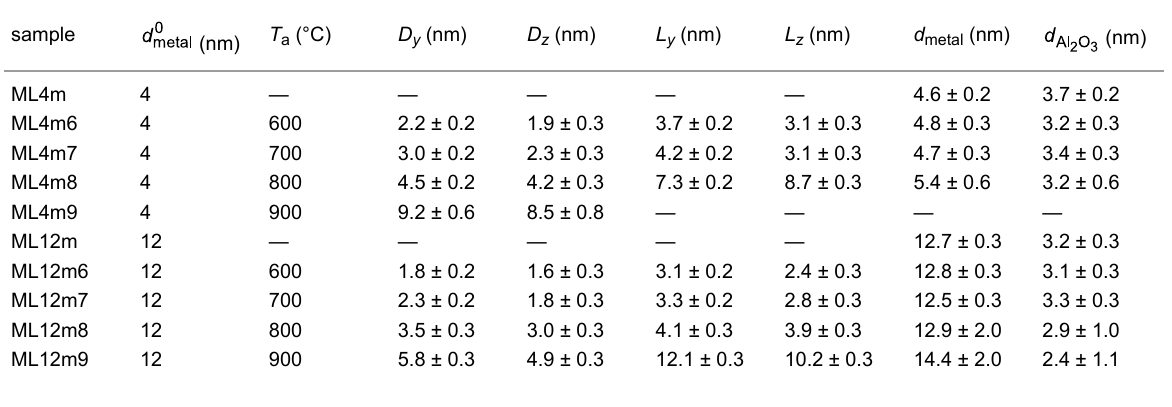
Table 1: Results of the numerical analysis of GISAXS patterns and XRR curves for the MLs prepared with two different nominal thicknesses for the metallic layers and annealed at different temperatures T a . The average dimensions (separations) of nanoparticles in the directions parallel and perpendicular to the surface of the film are denoted as D y ( L y ) and D z ( L z ), respectively, and were derived from the GISAXS patterns. The thickness of metallic layers d metal and the thickness of the spacer layers were obtained from XRR